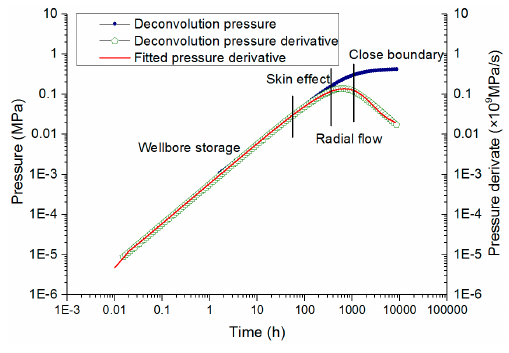
Figure 6. H3-1 deconvolution well-test double logarithmic curve.